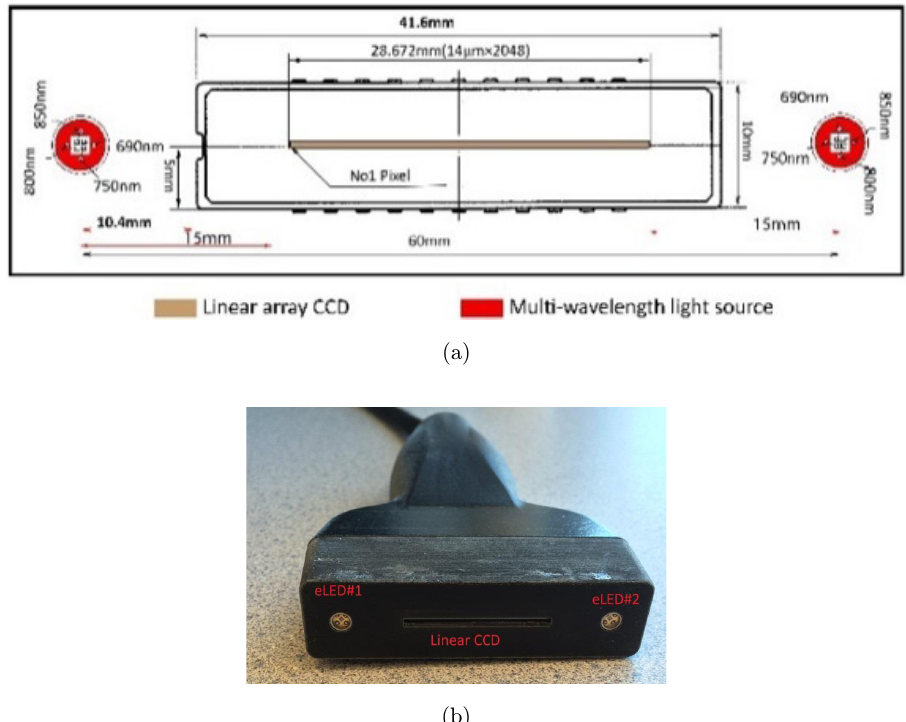
Fig. 1. (a) Front-end light sources and linear charge coupled device (CCD) orientation on the probe and (b) Photograph of DOB-Scan